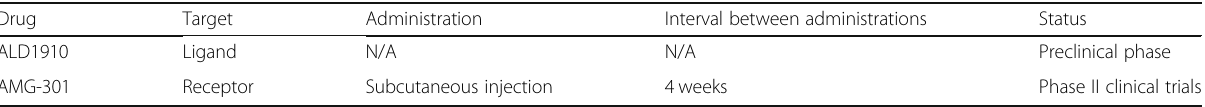
Table 4 Overview of anti-pituitary adenylate cyclase-activating polypeptide/pituitaryadenylate cyclase 1 (PACAP/PAC 1 ) monoclonal